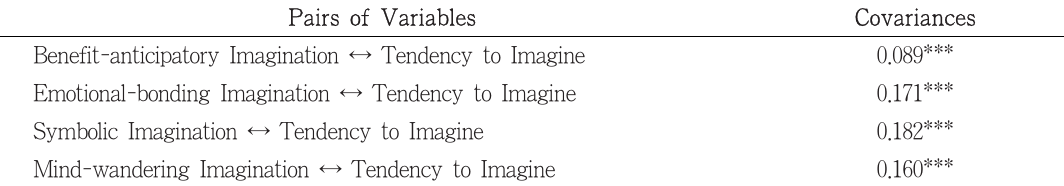
Pairs of Variables Covariances Benefit-anticipatory Imagination ↔ Tendency to Imagine